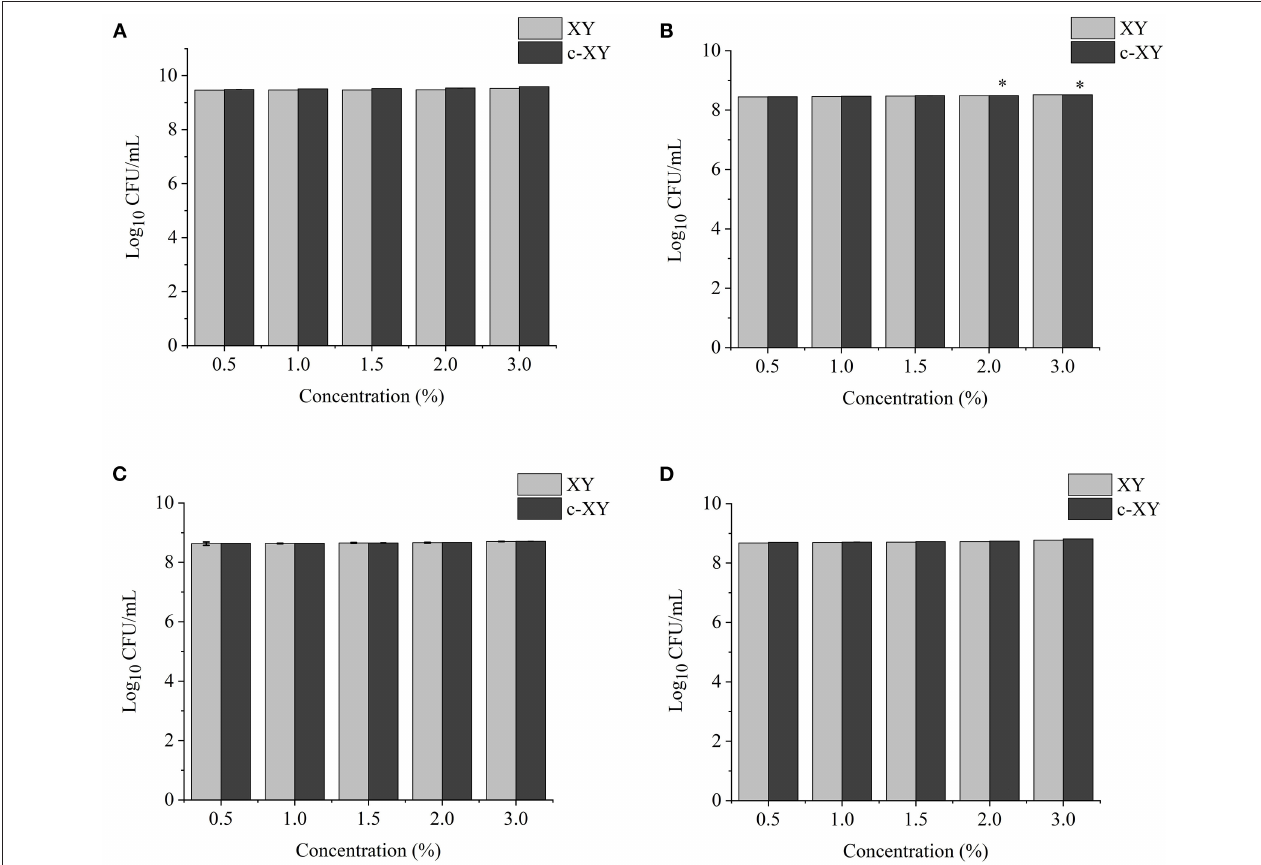
FIGURE 3 | Effects of different concentrations of carboxymethylated xylan (c-XY) sample on the growth of probiotics (A) L. brevis , (B) L. plantarum , (C) L. delbrueckii subsp. bulgaricus , and (D) S. thermophilus . * P < 0.05.